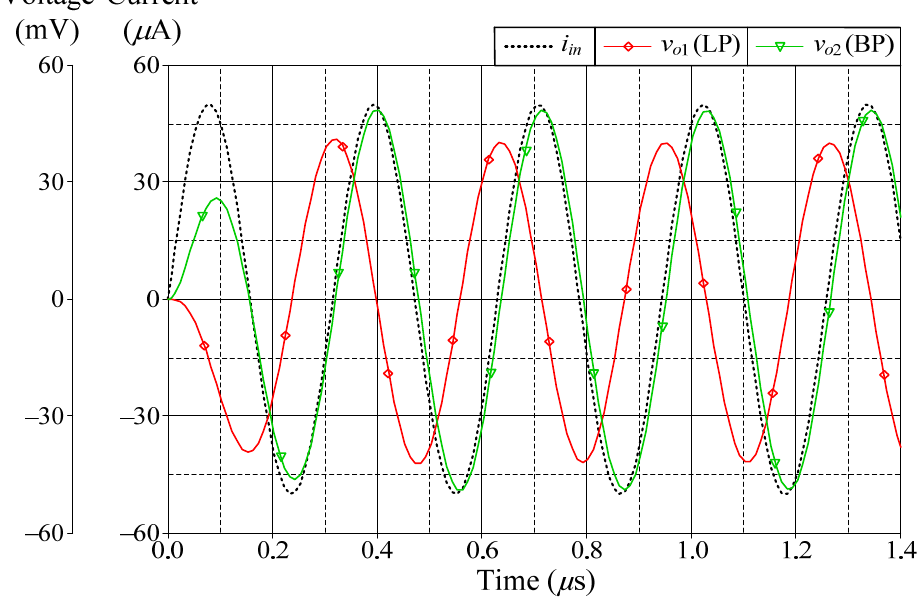
Figure 13. Time-domain responses of the LP and BP filters in TIM.